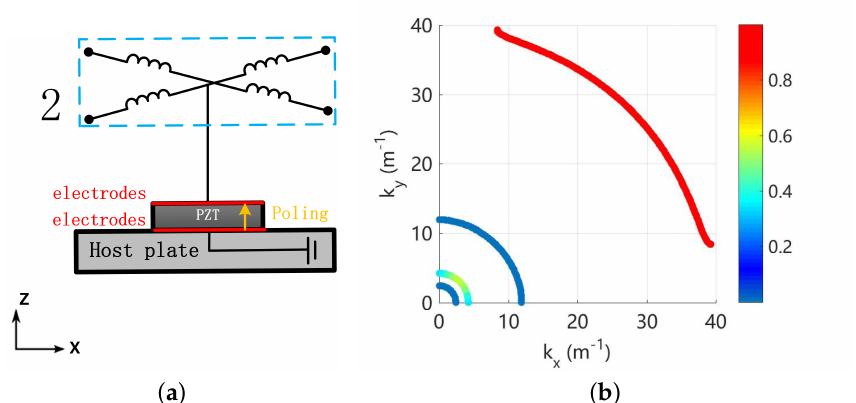
Figure 9. Wavenumber of the propagation waves ( b ) at 800 Hz for unit cell with single-sided PZT patch ( a ), coloured by RSW f .